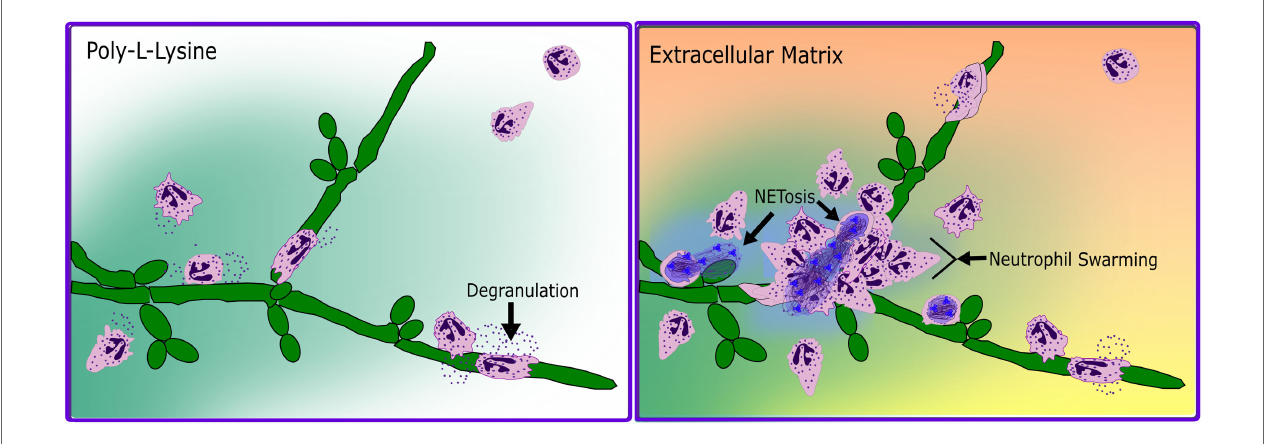
FiGURe 1 | Schematized neutrophil response to C. albicans hyphae in the absence and presence of extracellular matrix . In the absence of ECM (poly- l -lysine, left panel), neutrophils respond to hyphae by chemotaxis, by degranulation and respiratory burst, and by wrapping around fungal filaments in a form of frustrated phagocytosis. In the presence of ECM (Extracellular Matrix, right panel), neutrophils chemotaxis to fungal filaments is faster and more directed, with degranulation and respiratory burst being actively suppressed until the multifocal contact of frustrated phagocytosis. Additionally, in a subset of cells contacting the fungal hyphae, a rapid, respiratory burst independent NETotic response is induced and followed by neutrophil